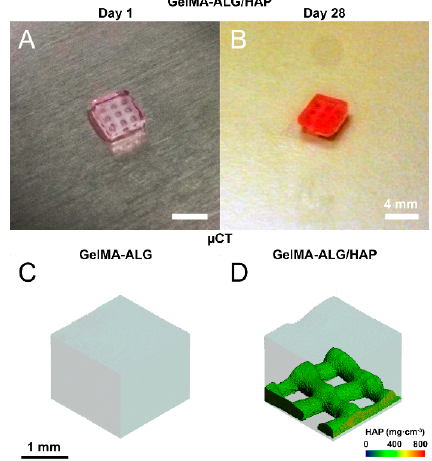
Figure 2. Images of hydrogel/scaffold hybrid constructs. ( A ) photo illustrating ALG/HAP scaffolds crosslinked within GelMA hydrogels on day 1 and ( B ) day 28. Scale bar 4 mm; ( C , D ) scaffolds imaged using micro-computed tomography (µCT), with thresholding used to isolate high density components (colored scale illustrates mg·cm − 3 of HAP); ( C ) GelMA-ALG and ( D ) GelMA-ALG/HAP illustrated, scale bar 1 mm as indicated.